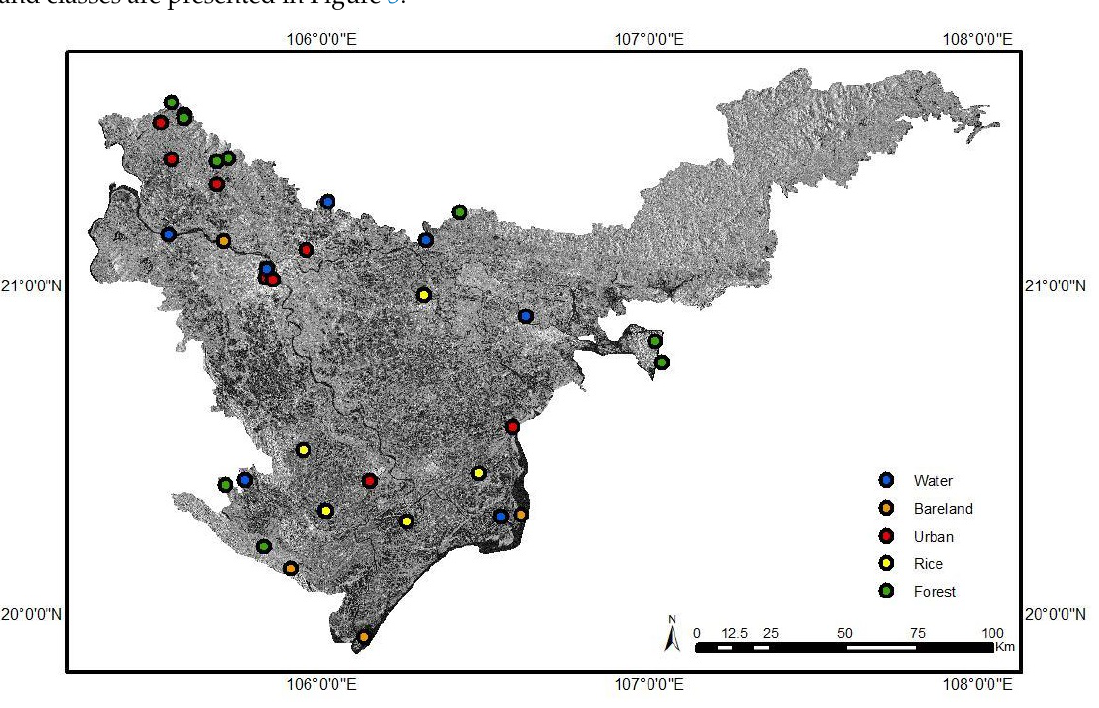
Figure 4. Test sizes for phenology analysis in the Red River Delta